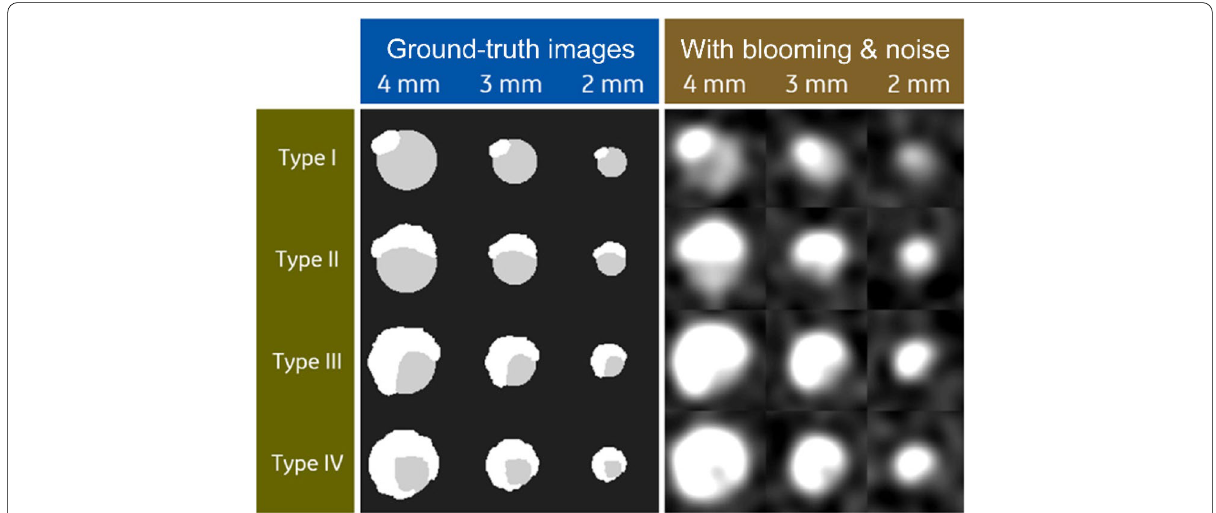
Fig. 4 Four plaque types (as defined by Qi et al. [13]) are simulated here in 3 sizes (with 4, 3, and 2 mm unobstructed diameters). The calcium (white, 1750 Hounsfield units (HU)) is blurred by the system point spread function such that it obscures much of the lumen (light gray, 600 HU) in many cases. The original (ground truth, high resolution) images are shown in the left panel. The right panel simulates the effects of finite system resolution and noise (W/L 1000/300 =